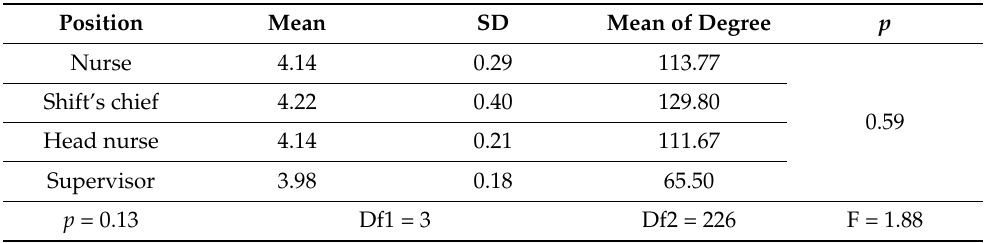
Table 4. The mean scores of the factors affecting the compliance of nurses with using PPE according to the nurses’ positions.